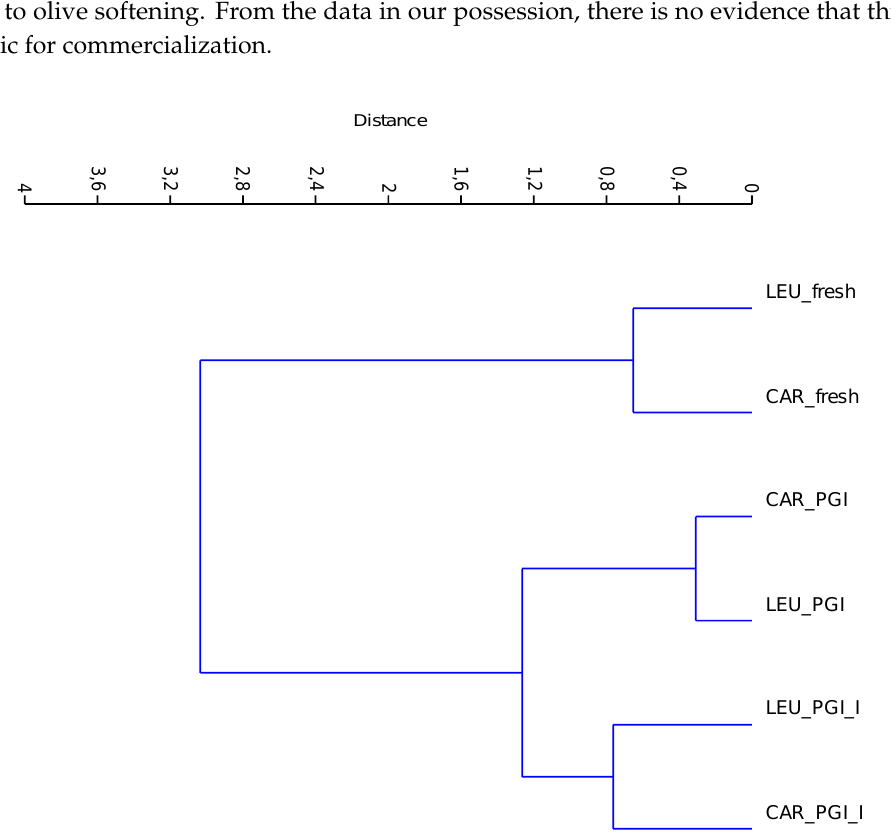
Figure 5. CA dendrogram of data-set based on mineral composition. Dendrogram is obtained using the Ward’s algorithm and the Euclidean distance similarity. CAR_fresh: Carolea fresh, LEU_fresh: Leucocarpa fresh; CAR_PGI: Carolea fermented in PGI sea salt; LEU_PGI: Leucocarpa fermented in PGI sea salt; CAR_PGI_I: Carolea fermented in iodized PGI sea salt; LEU_PGI_I: Leucocarpa fermented in iodized PGI sea salt.